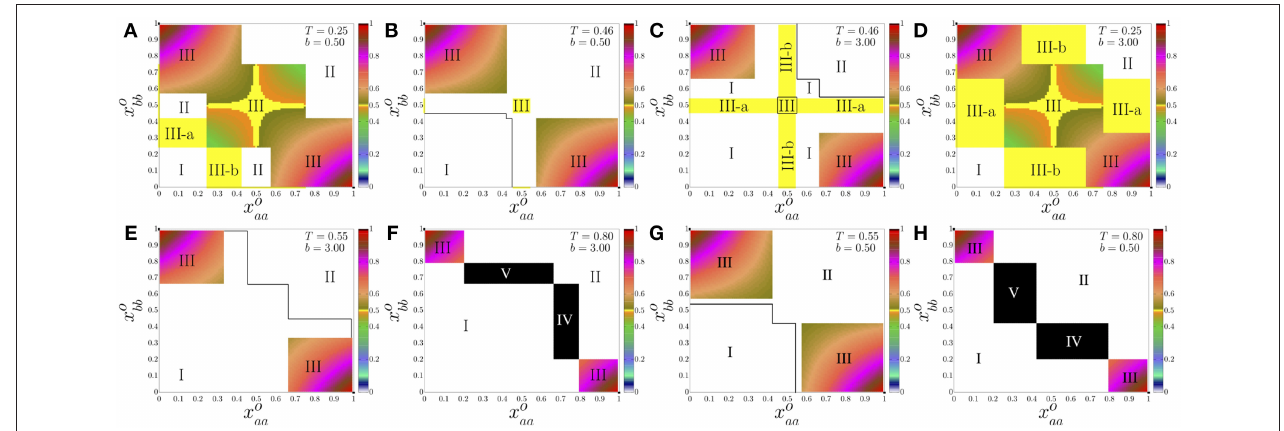
FIGURE 5 | Plot in color scale of the fraction of active links between layer A and B in the asymptotic solution of the dynamics as a function of the initial density of x aa and x bb for the Asymmetric Coordination Game. The color scale defines the values of the fraction of actives links, n AB = 1 black color and n AB = 0 white color. Asymptotic solutions are as indicated. (A–H) Correspond to the values of the threshold T and parameter b indicated by red dots in Figure 2 . (A) T = 0.25, b = 0.50, (B) T = 0.46, b = 0.50, (C) T = 0.25, b = 0.30, (D) T = 0.25, b = 3.00, (E) T = 0.55, b = 3.00, (F) T = 0.80, b = 3.00, (G) T = 0.55, b = 0.50, (H) T = 0.80, b = 0.50. System size, N A + N B = 1000 + 1000 =